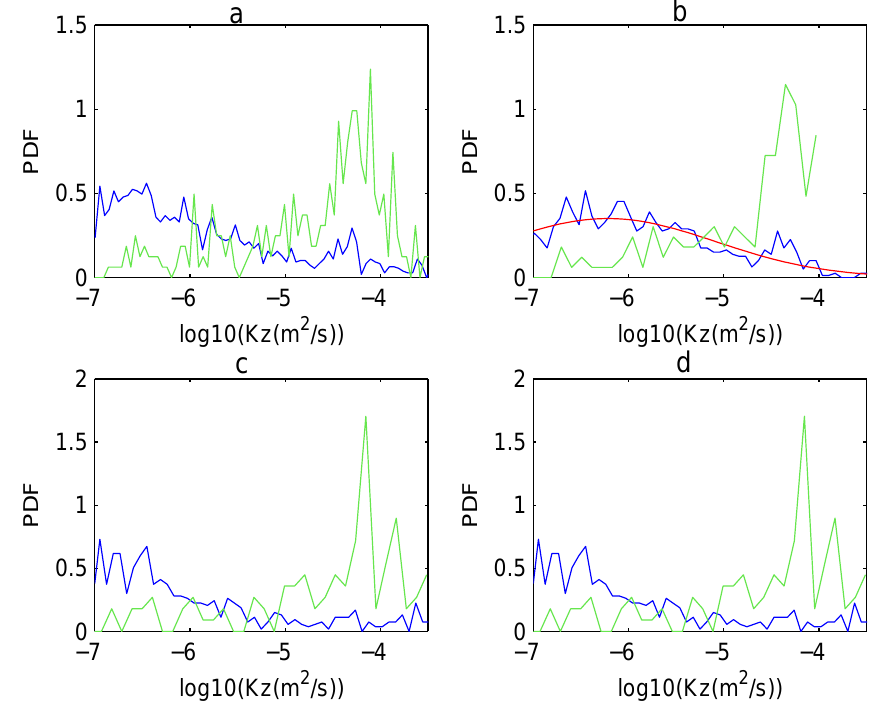
Fig. 7. Experimental PDF of Log 10 (K z ( m 2 s . − 1 )) in blue for 10m < z < 20m in blue for 20m < z < 100m in red MLE fit of a log-normal Figure 7: Experimental PDF of Log 10 ( K z ( m 2 . s . − 1 )) in blue for 10m<z<20m in blue for PDF, (a) for the complete LD station data set (stations A, B, C), (b) for station C, (c) for station B and (d) for station A. 20m<z<100m in red MLE (cid:28)t of a log-normal PDF, (a) for the complete LD station data set (stations A,B,C), (b) for station C, (c) for station B and (d) for station A.